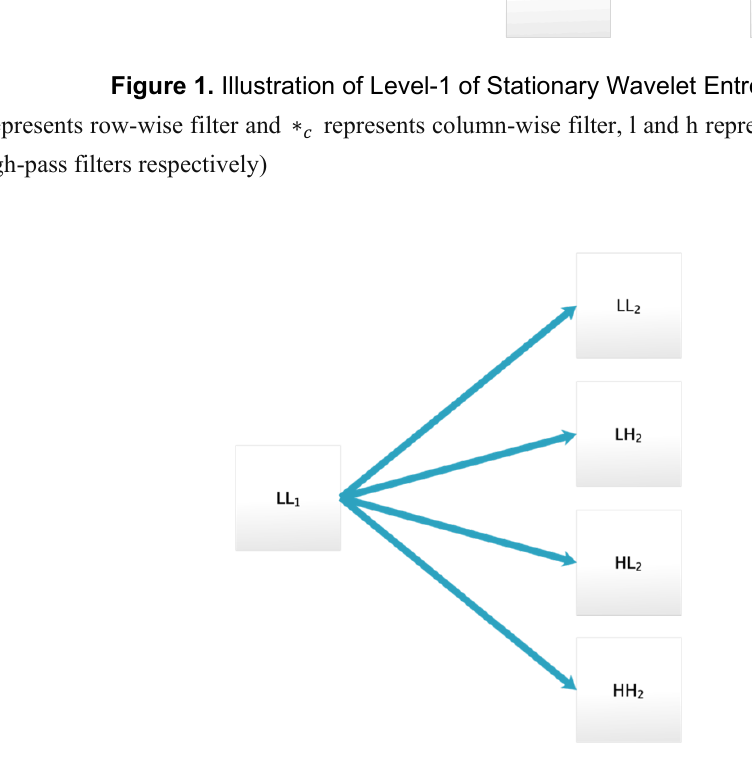
Figure 2. Illustration of Level-2 of Stationary Wavelet Entropy.